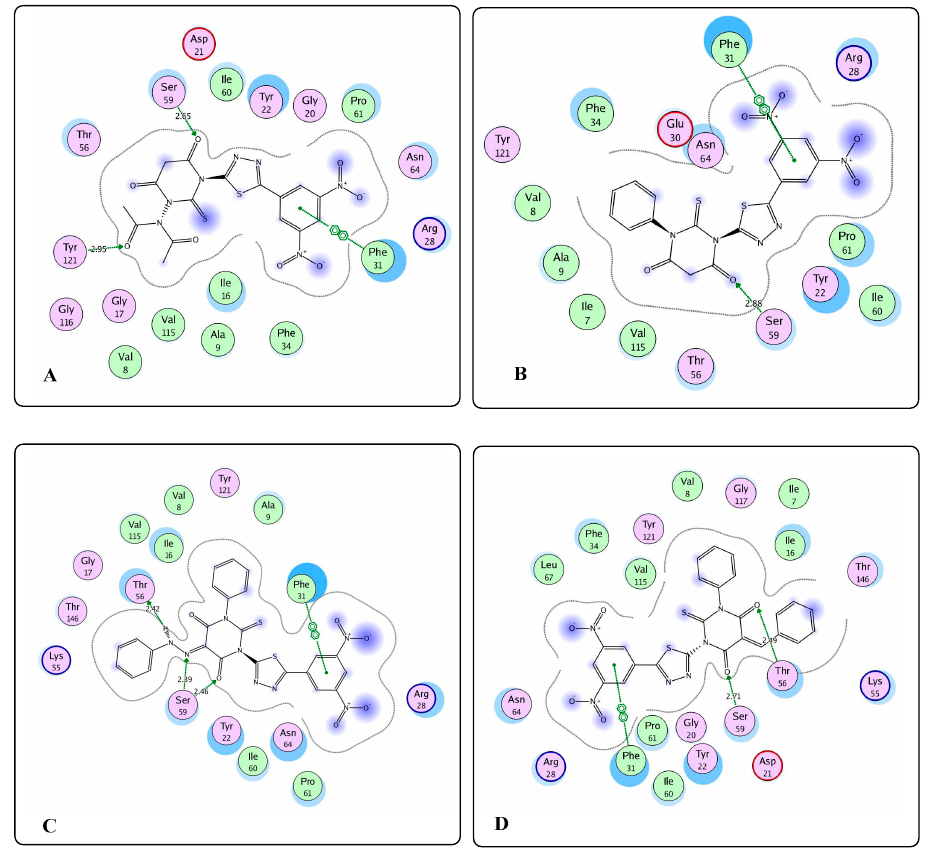
Figure 5. Two-dimensional representation of the interactions of compounds 10 ( A ), 13 ( B ), 14 ( C ), and 15 ( D ) with the DHFR enzyme pocket amino acids.